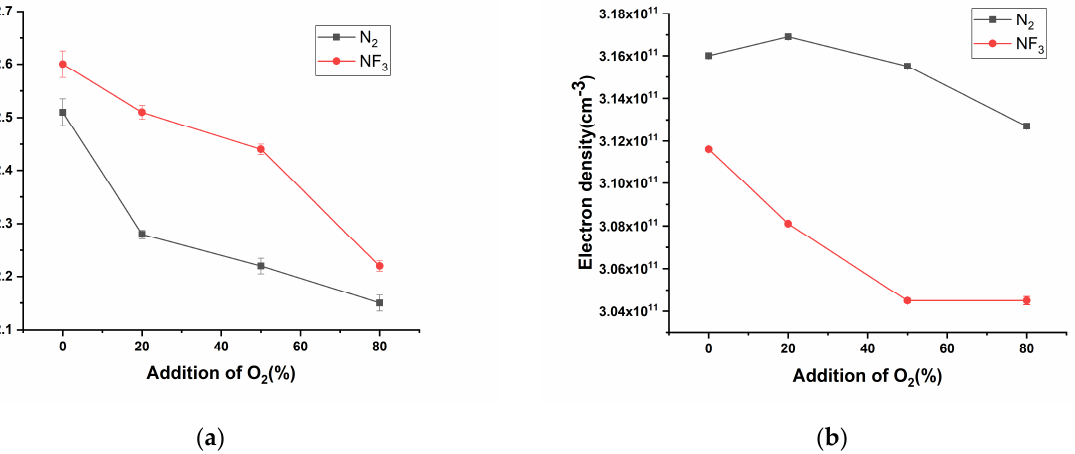
Figure 9. Plasma information of N 2 and NF 3 according to the amount of oxygen added: ( a ) electron temperature and ( b ) electron density.